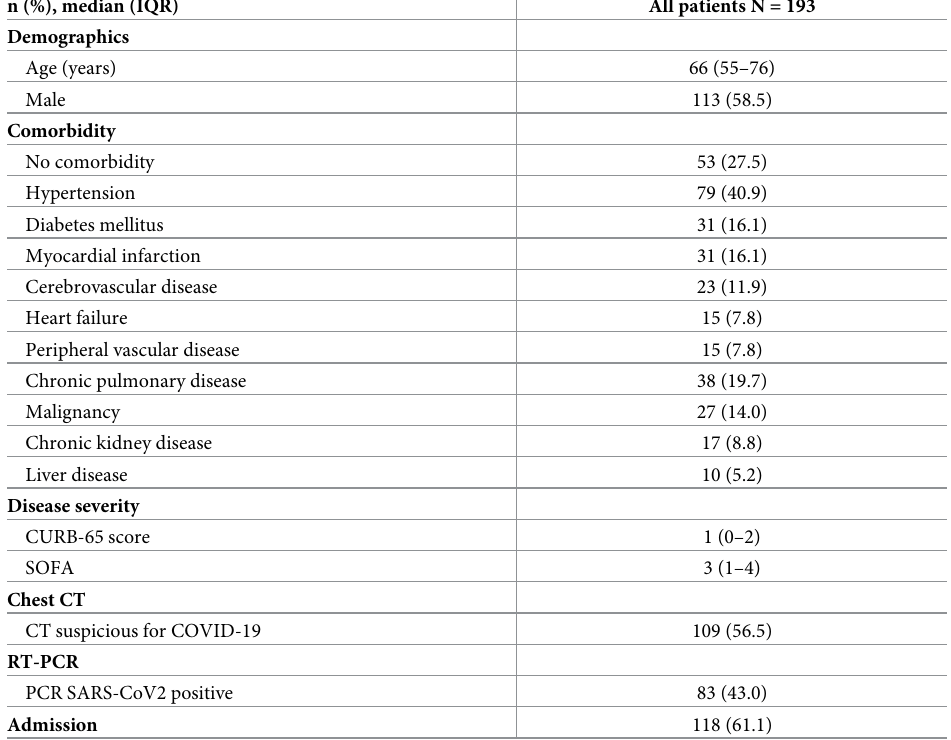
Table 1. Patient characteristics.